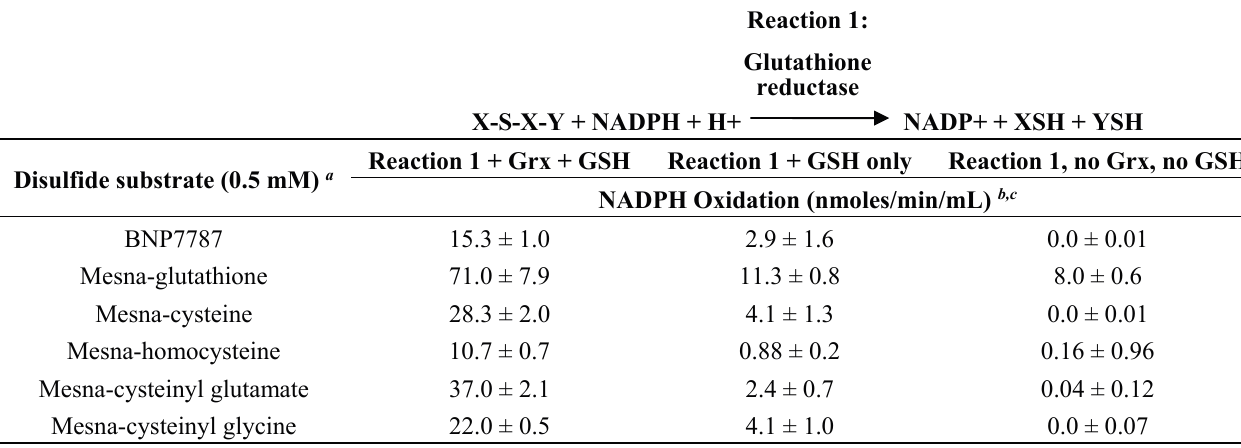
Table 1. The Interaction of BNP7787 and BNP7787-derived mesna disulfide heteroconjugates with glutaredoxin (GRX) (using glutathione reductase as a coupling enzyme with varying reaction conditions +/ − Grx and/or +/ −